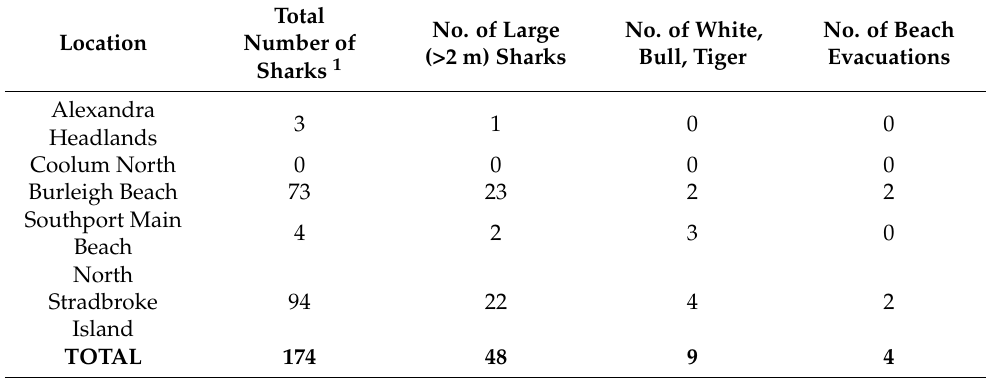
Table 3. Number of sharks sighted at Queensland SharkSmart drone trial